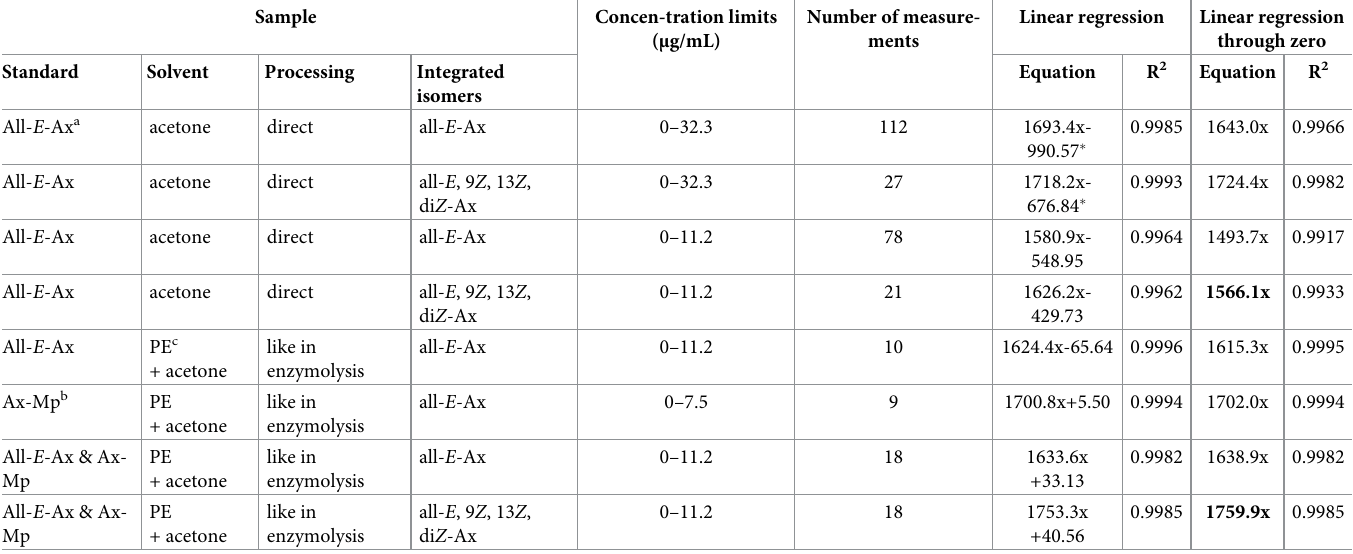
Table 1. Calibration curves of astaxanthin